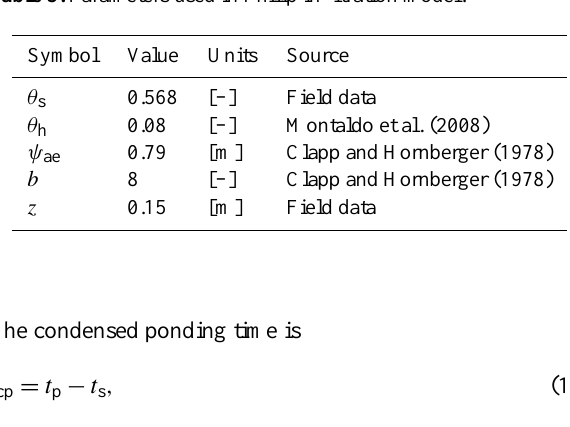
Table 3. Parameters used in Philip infiltration